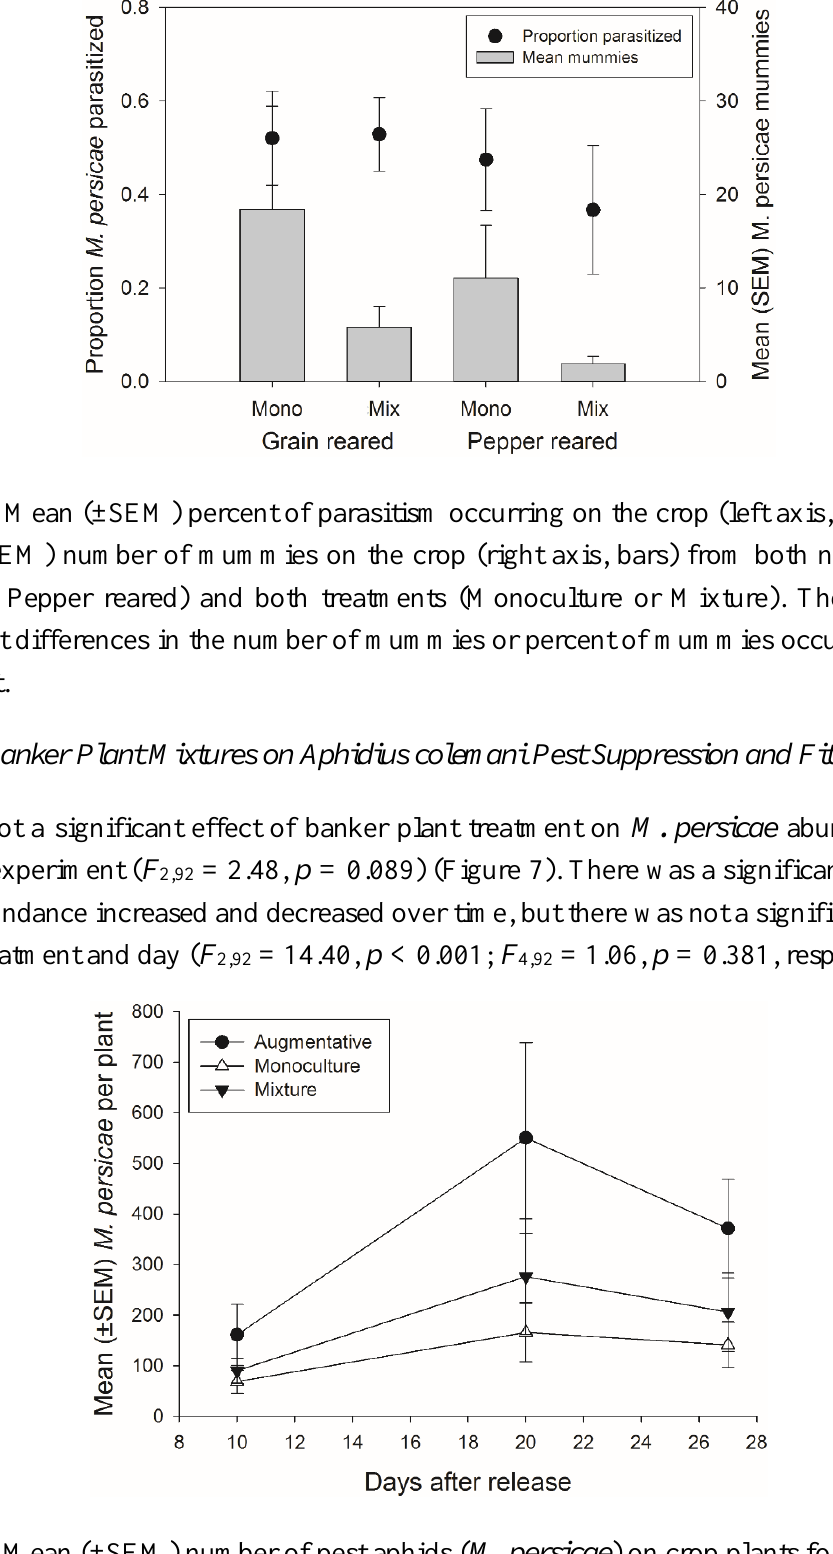
Figure 7. Mean (±SEM) number of pest aphids ( M. persicae ) on crop plants for each of the three treatments monoculture, mixture, and augmentative per collection